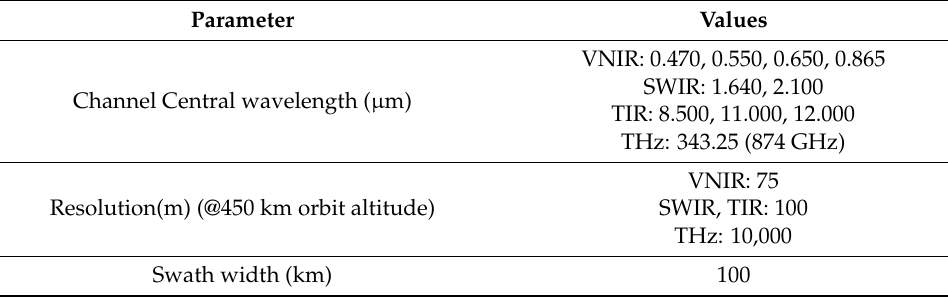
Table 1. Optical design